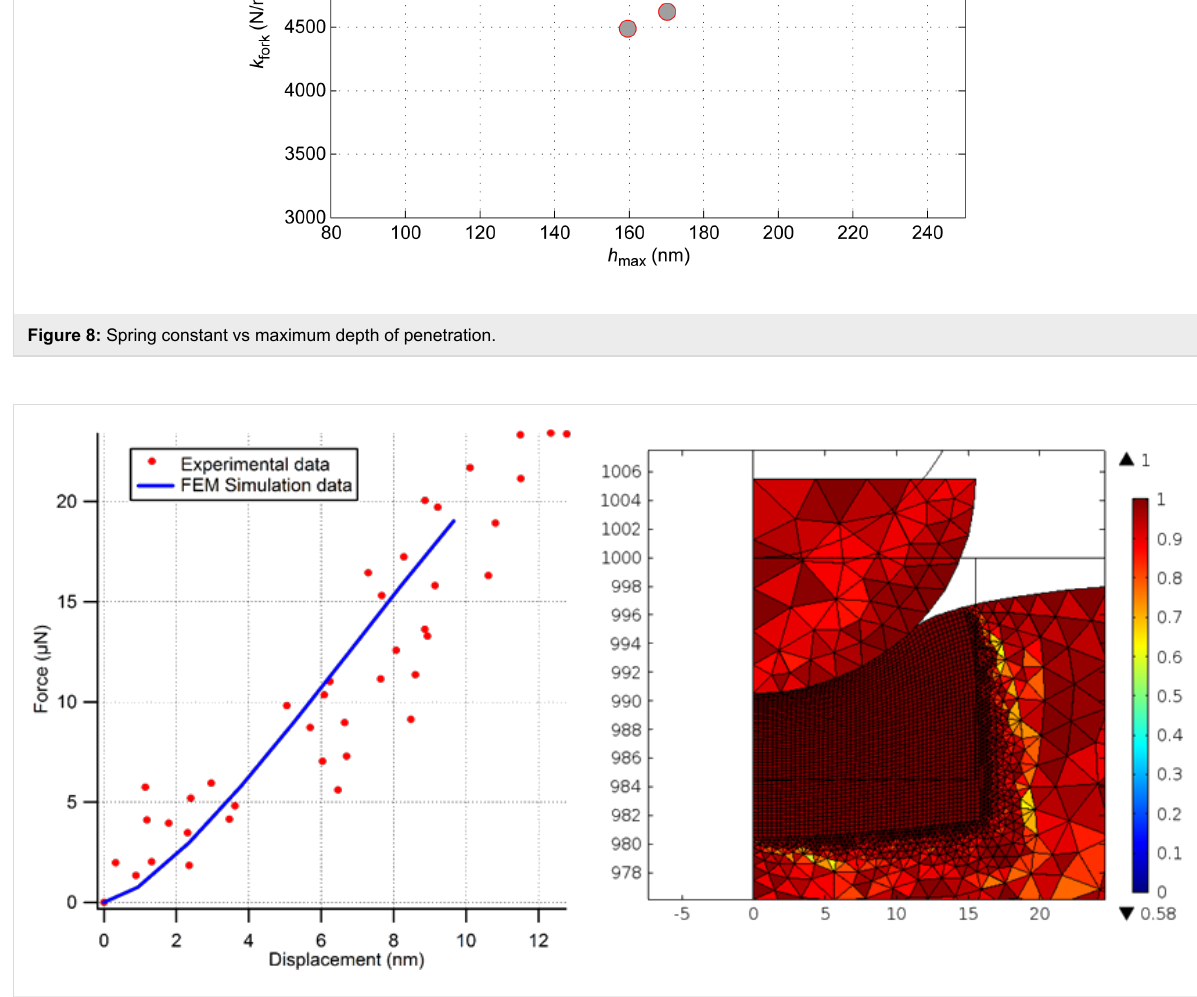
Figure 9: Finite element analysis data as compared to experimental data.